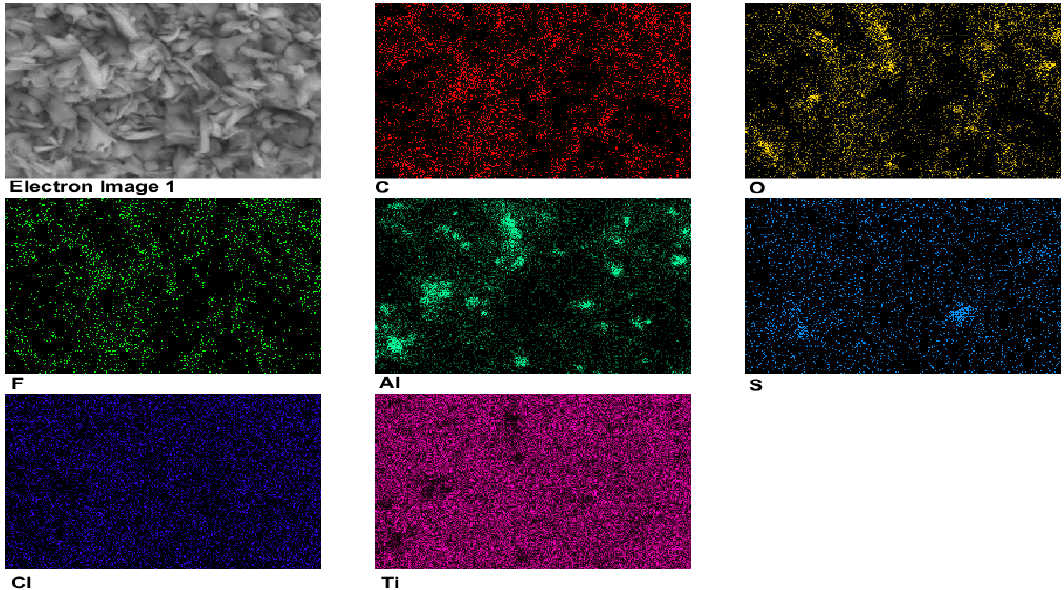
Figure 4. EDX mapping of the synthesized MXene nanoparticle.